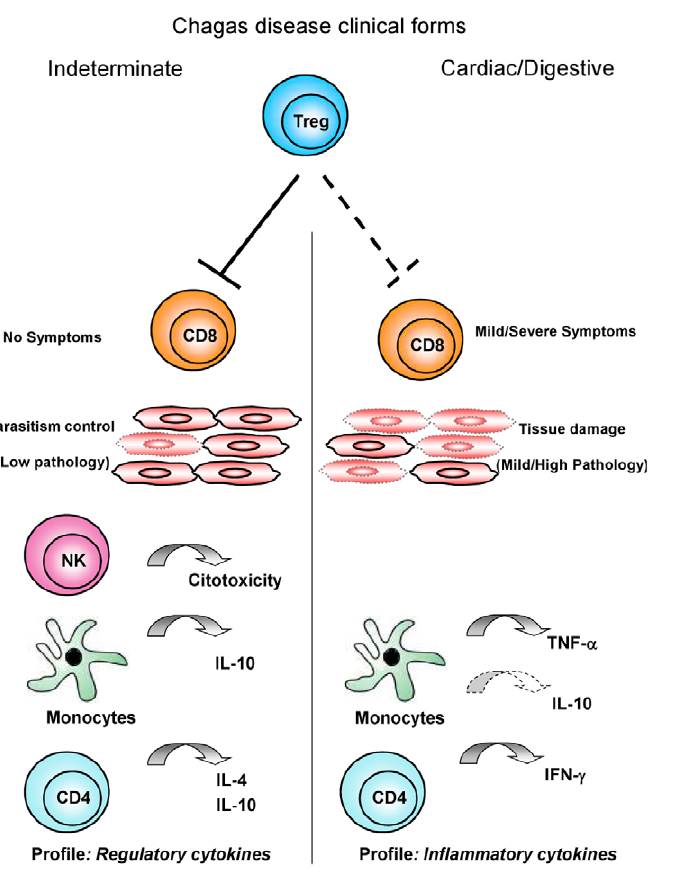
Figure 4. Proposed hypothesis for CD25 High CD4 + Treg cells function on immunoregulation in chronic Chagas’ disease. Several leukocyte subsets have been shown to play a role in immunoregulation during chronic infections. In this model, Chagas’ disease patients with the indeterminate clinical form show Treg cells able to modulate the effectors’ function of CD8 + T cells, in a microenvironment supported by cytotoxic NK-cells, Monocytes and CD4 + T cells producing regulatory cytokines (IL-10 and IL-10, IL-4, respectively). This immunological milieu contributes to controlling the parasitemia and regulating the immunopathology. On the other hand, Chagas’ disease patients with cardiac and digestive clinical forms display insufficient modulation by Treg cells with activated CD8 + T cells besides monocytes and CD4 + T cells producing inflammatory cytokines (TNF- a and IFN- c , respectively). This microenvironment triggers immunopathological events and leads to tissue damage in the absence of regulatory mechanisms and cytotoxic NK-cell